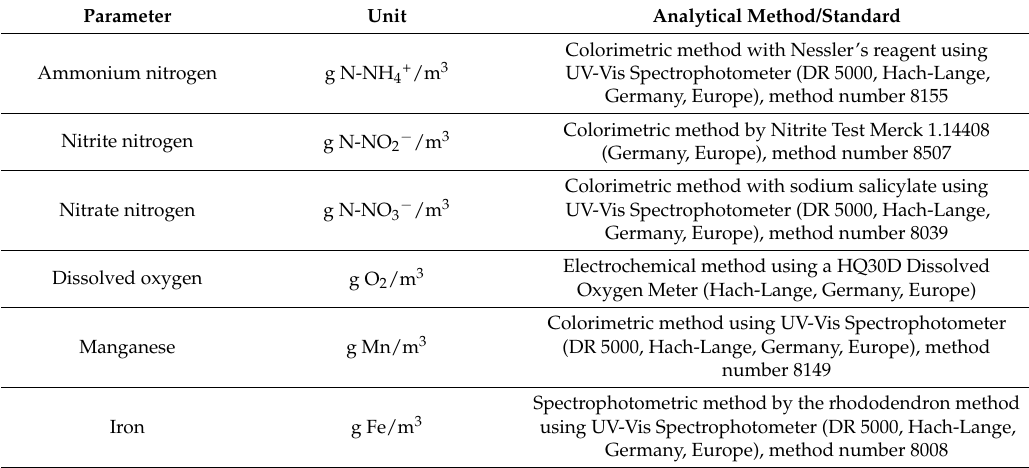
Table 5. Methodology of physicochemical determinations of water